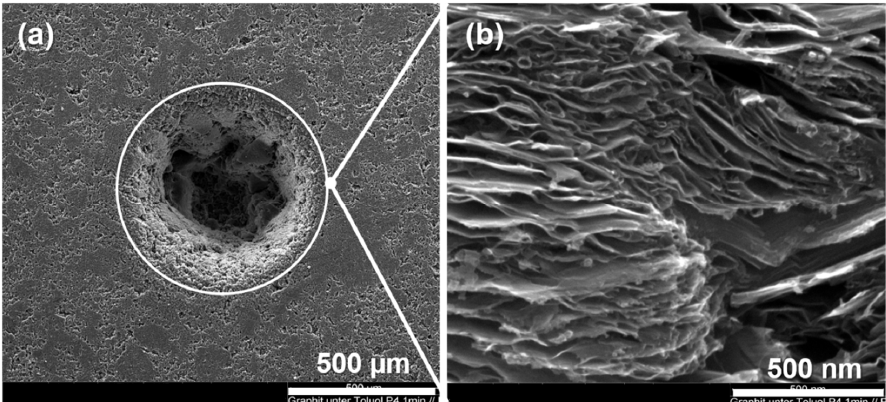
Figure 9. SEM images of a graphite target irradiated under a thin liquid toluene film: ( a ) the circle marks the position of zone 3 and ( b ) high-magnification SEM image within zone 3 (24 mJ, 30 s irradiation).